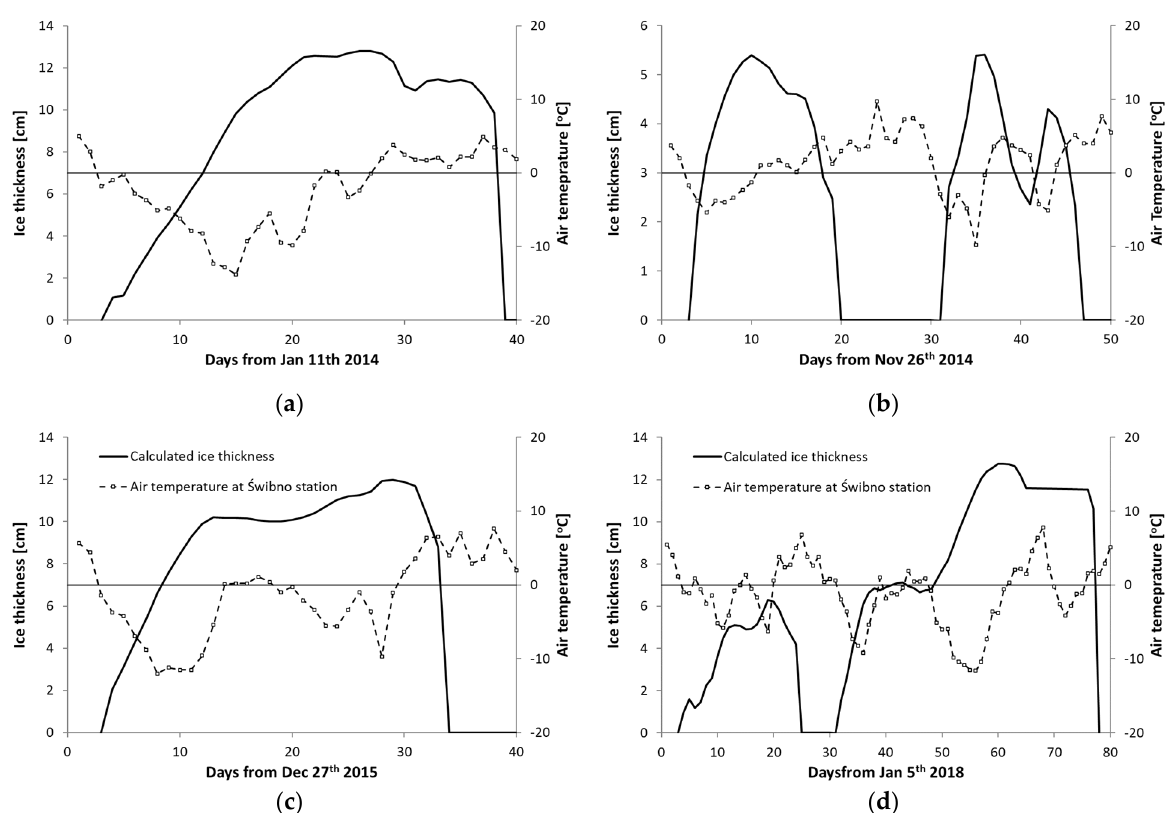
Figure 3. Calculated thickness of the ice cover on the Ł apino reservoir in the winter season 2016/2017 based on the sum of negative temperatures of the IMWM station in ( a ) Ś wibno and ( b ) Szadó ł ki.